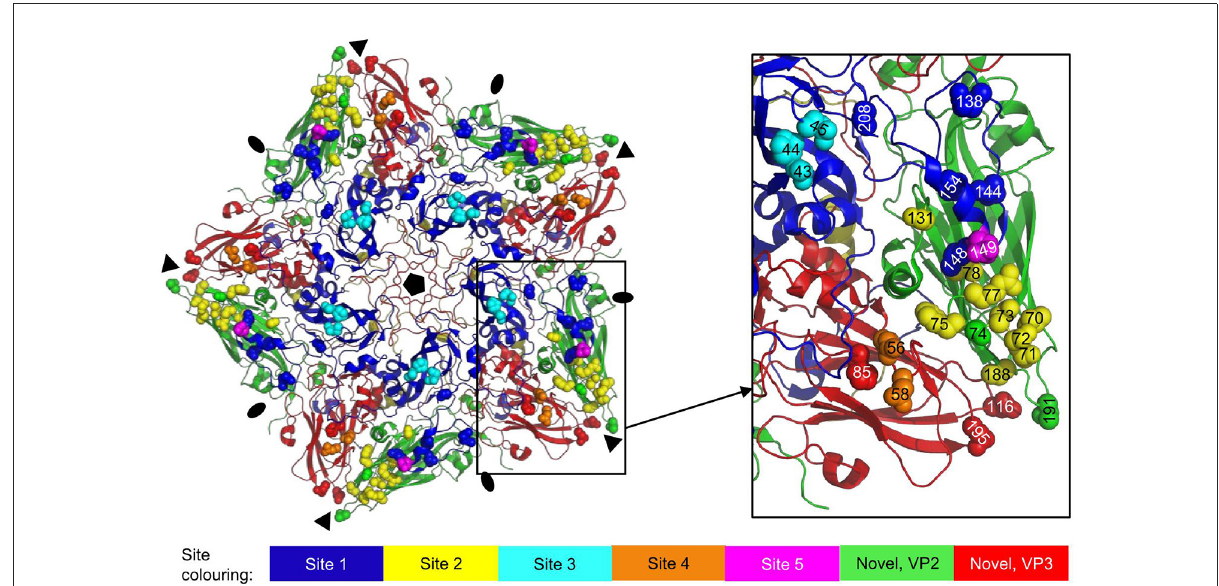
FIGURE7 Antigenic sites 1-5 as earlier identified by sequence analysis of mAb escape mutants mapped onto the 3D structure of an O1K (PDB: 1FOD) pentamer. VPs are shown as cartoon: VP1, blue; VP2, green; VP3, red; VP4, yellow. Side chains of residues defining the antigenic sites are shown as spheres in different colors for sites 1-5 and in case of the novel site (16, 38) also VP2 and VP3 residues. Fivefold symmetry axis, pentagon; 3-fold symmetry axis, triangle; 2-fold symmetry axis,